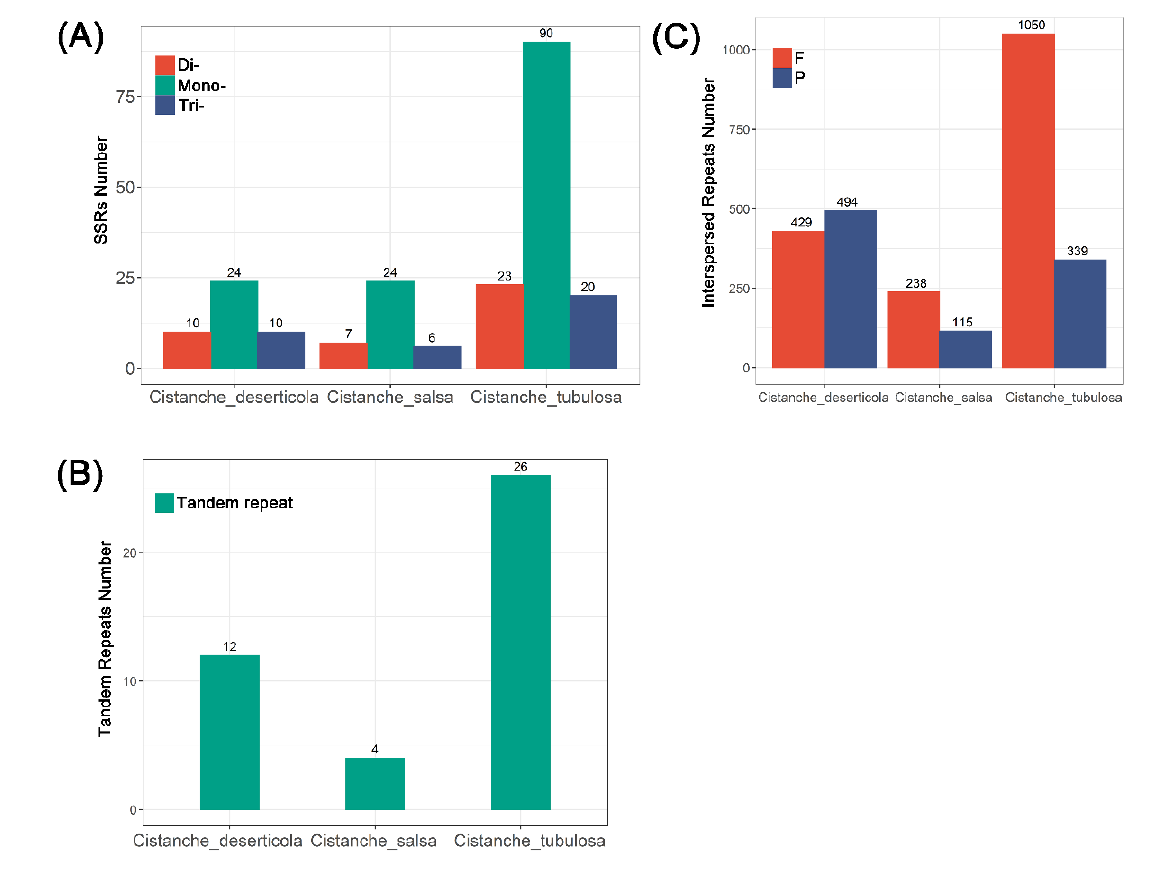
Figure 2. Simple sequence repeats (SSRs), interspersed repeats and tandem repeats in 3 Cistanche species mitogenomes. ( A ) Comparison of SSRs among the three mitogenomes. Each color column represents a different SSR-repeat type. ( B ) Comparison of tandem repeats among the three mitogenomes. ( C ) Comparison of interspersed repeats in the three mitogenomes. Each color column represents a different interspersed-repeat type. The number of repeats in each category is shown on the top of the corresponding columns.